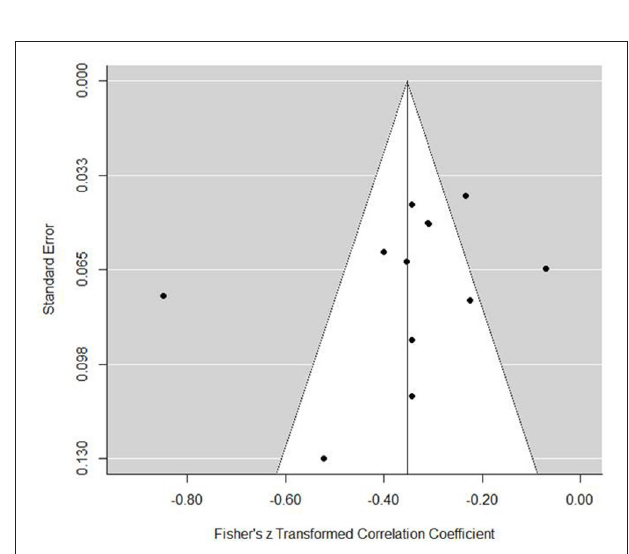
FIGURE 6 | Internal regulation coping funnel plot.